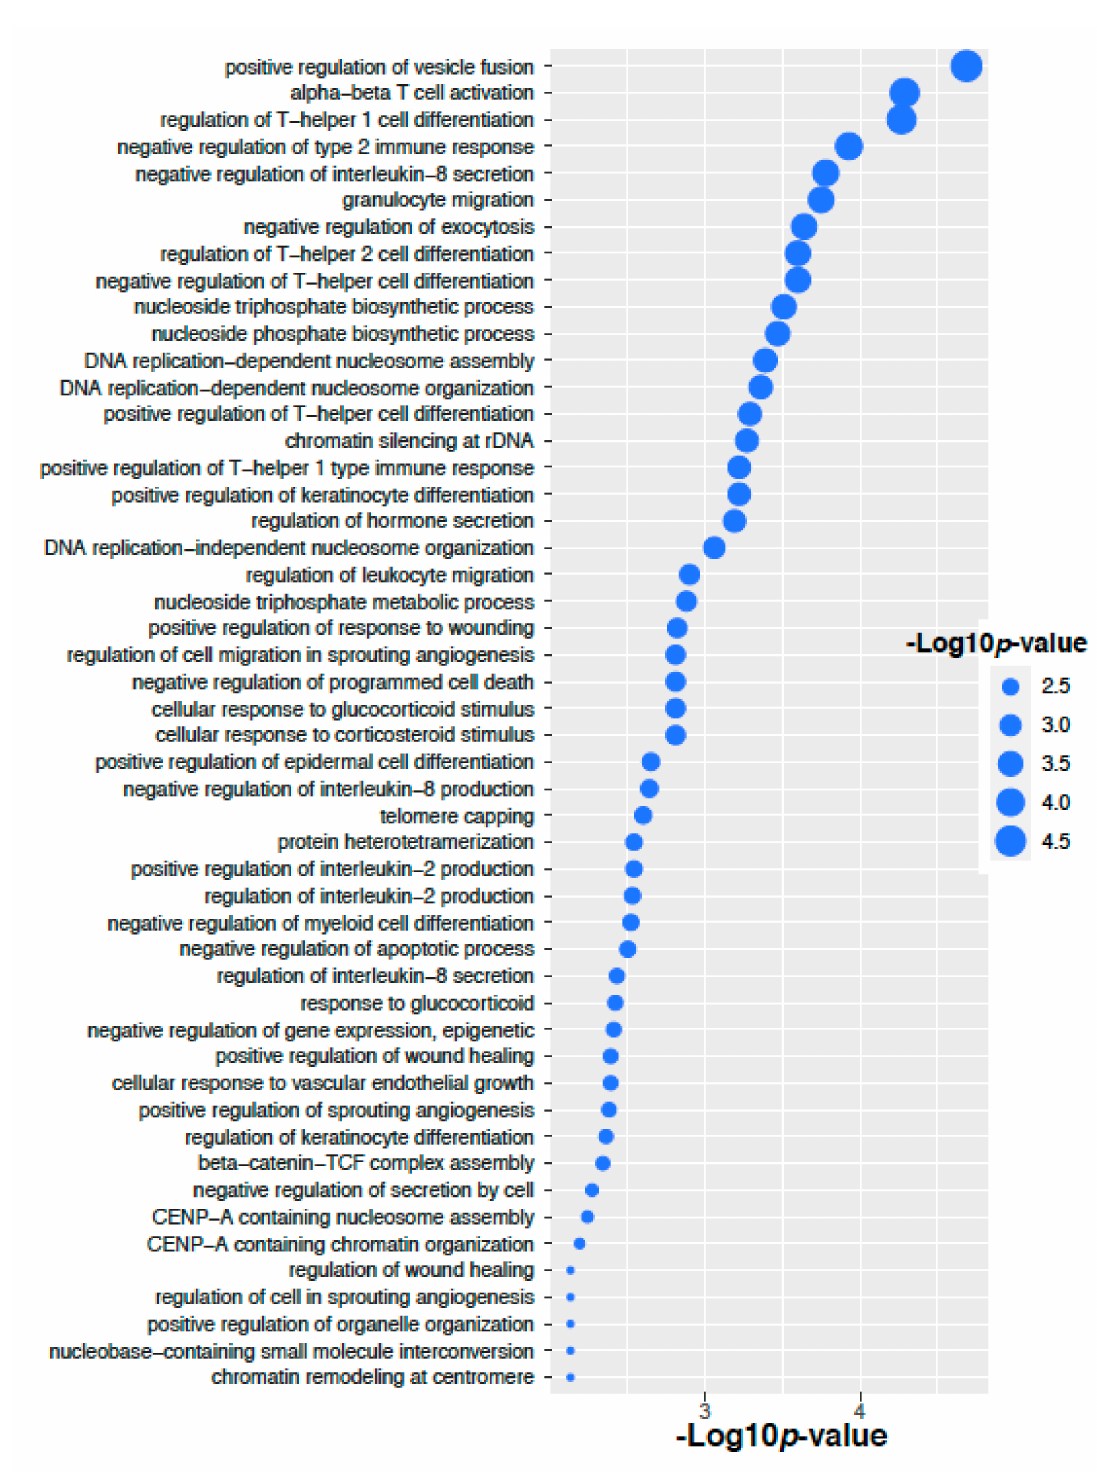
Figure 9. Gene Ontology enrichment of the genes corresponding to the altered 3 proteins in colorectal